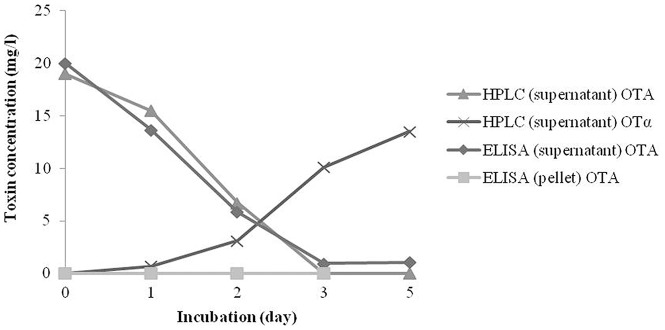
Ochratoxin-A biodegradation by Cupriavidus basilensis ŐR16 during 5 day incubation.Continuous decrease of the OTA concentration is detected in the supernatant and pellet, while OTα concentration is increasing. Abbreviations: HPLC (supernatant OTA) – OTA concentration in the supernatant originated from the degradation experiment measured by HPLC, HPLC (supernatant OTα) – OTα concentration in the supernatant originated from the degradation experiment measured by HPLC, ELISA (supernatant) OTA – OTA concentration in the supernatant originated from the degradation experiment measured by ELISA, ELISA (pellet) OTA – OTA concentration in the pellet originated from the degradation experiment measured by ELISA. Measurements were carried out in triplicate, SD>3%.